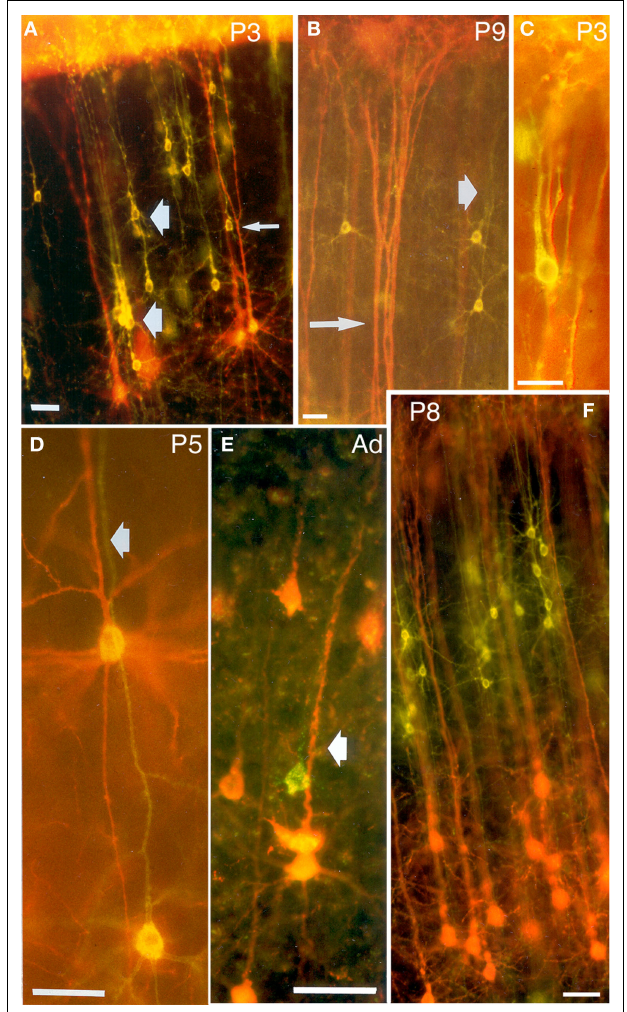
FIGURE 3 | Double exposures photomicrographs of coronal sections of double-labeled brains. In (A,B) , callosally projecting (DiA, yellow-green) and corticocollicular (DiI, orange-red) neurons form separate bundles in the visual cortex of P3 and P9 rats. (A) Bundles are indicated by thick arrows, whereas the thin arrow points to a callosally projecting neuron whose apical dendrite, at higher magnifi cation, was found to be separated from the corticocollicular ones on the z -axis. (B) The thin arrow points to a corticocollicular dendritic bundle, and the thick one to a callosally projecting bundle. (C) A bundle comprising apical dendrites of callosally projecting (DiI, orange-red) and corticostriatal neurons (DiA, yellow-green), in a P3 rat. (D,E) callosally projecting (DiI and fl uoro-ruby, respectively, orange-red) and ipsilaterally projecting corticocortical (DiA and fl uoro-emerald, respectively, yellow-green) neurons in the visual cortex of P5 and adult rats establish common bundles (thick arrows). (F) Callosally projecting (DiA, yellow-green) and corticogeniculate (DiI, orange-red) neurons in the visual cortex of P8 rats. Scale bars, 50 µm (from Vercelli et al.,